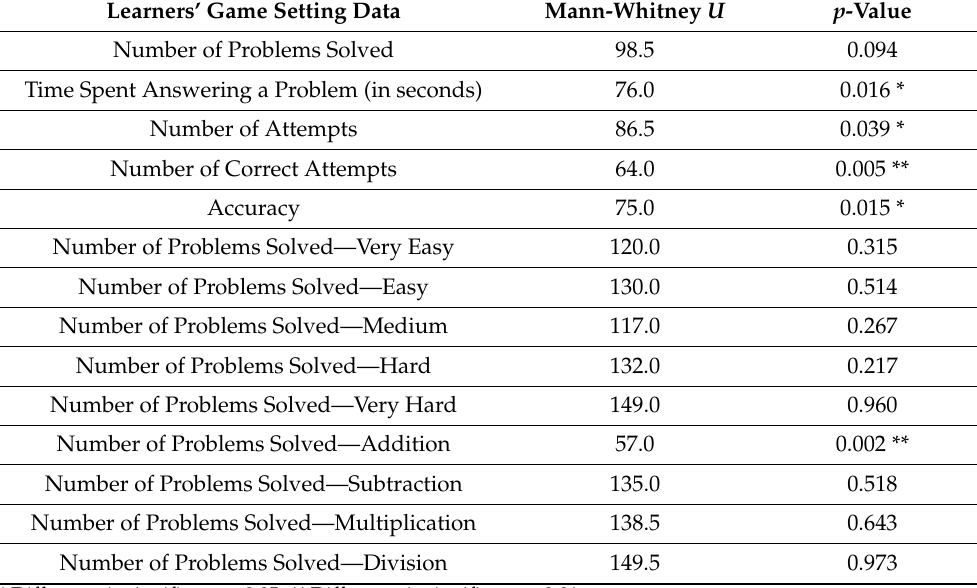
Table 6. Mann-Whitney U test was employed to determine whether there is significant difference on the game interaction data between hare and stag hunters. This statistical test confirms that there is a significant difference between the interactions of the groups in terms of time spent, number of attempts, number of correct attempts, accuracy, and number of addition problems